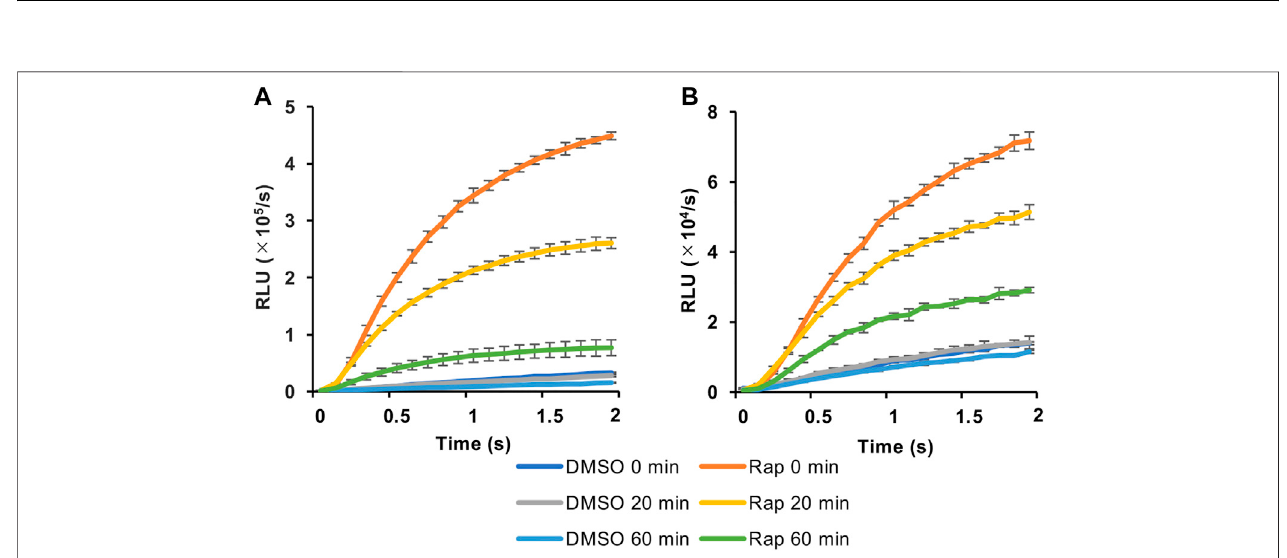
FIGURE 4 | Effect of preincubation in FlimPIA. (A) The pair of FKBP-Ppy Donor and FRB-Ppy Acceptor. (B) The pair of FKBP-Ppy Donor and FRB-LlL Acceptor. After the incubation at 37 ° C FlimPIAwas performed.Error bar: ± 1 × SD ( n (cid:2) 3). Donor (50 nM) and Acceptor (50 nM) were reacted with LH 2 (33 μ M) and ATP (1.25 mM) with/without rapamycin (Rap, 50 nM). The reaction buffer was added with 1 mM of coenzyme